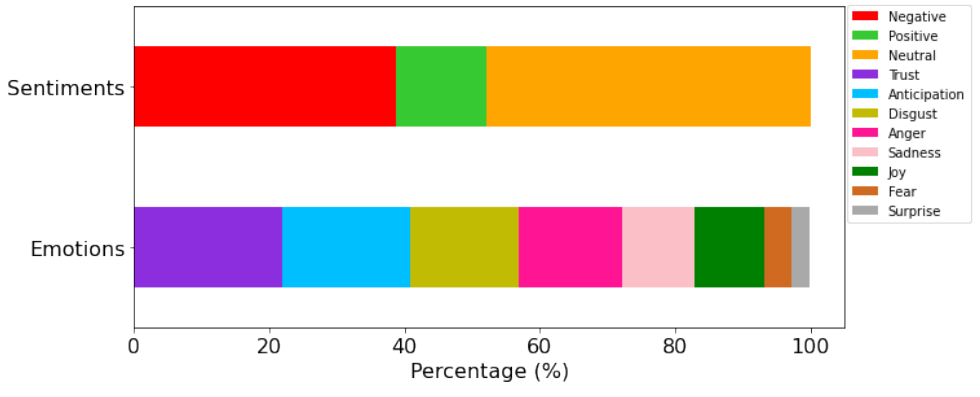
Figure 4. Global sentiment and emotion percentages.